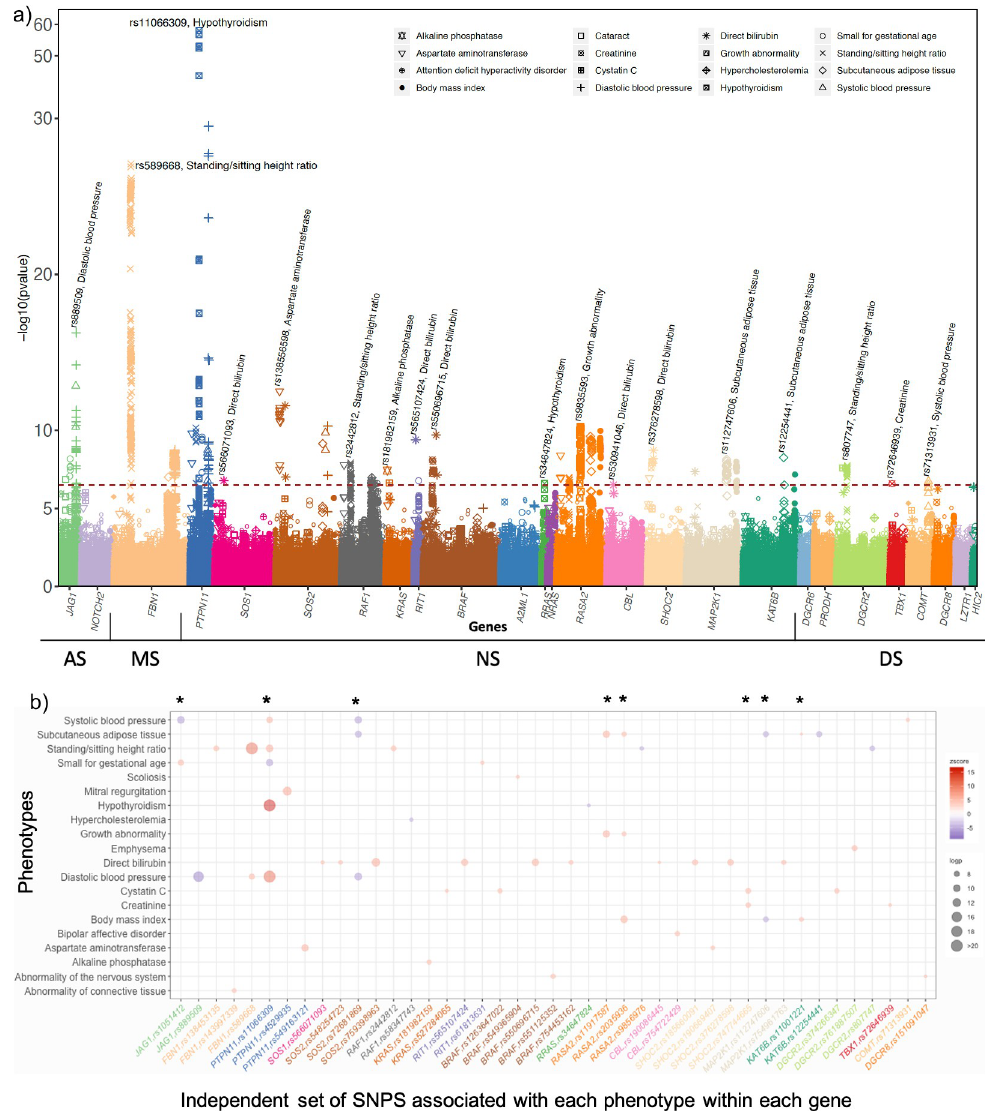
Fig 1. Primary PheWAS results: Variant level findings are displayed in panel (a) The red line represents the level of significance after Bonferroni correction (p < 2.7x10 -07 ). The color indicates variant in each gene and the shape indicates each phenotype (ex: variants in PTPN11 are represented in blue, and the association with diastolic blood pressure indicated with the sign +). Correlation plot of association between phenotypes and the subset of independent variants within each gene is displayed in panel (b). The points represent the z-score and the color represent the direction of the association. The color varies from purple (inverse association) to red (positive association). The size of the point corresponds to the p-value (-log10(p)); the stars indicate variants associated with multiple